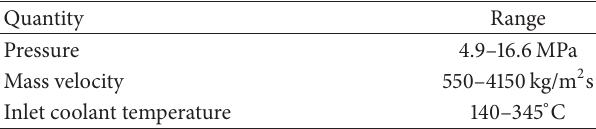
Table 1: Range of NUPEC PWR test facility operating